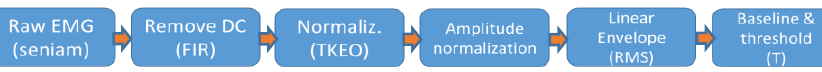
Figure 4. Data processing chain.